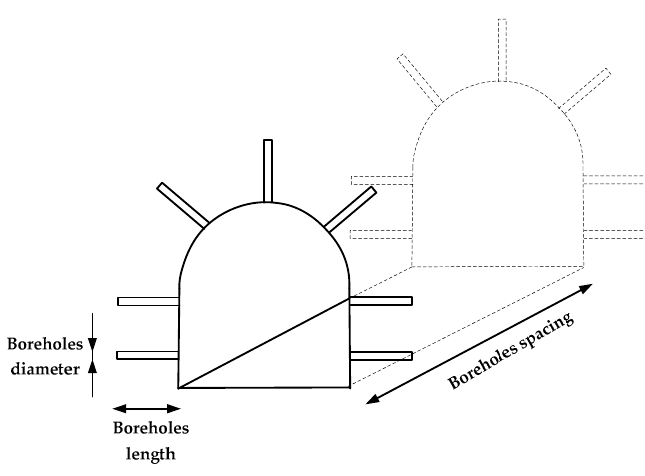
Figure 5. Arrangement of boreholes.